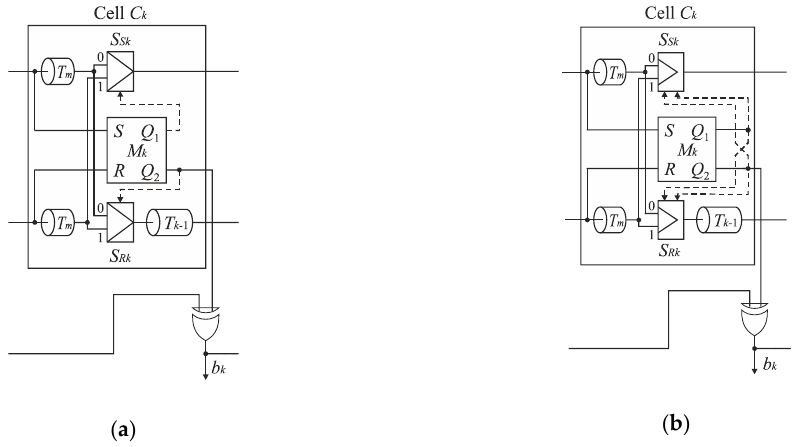
Figure 35. Cell of SA-TDC with classic ( a ) symmetrized ( b ) multiplexers design.